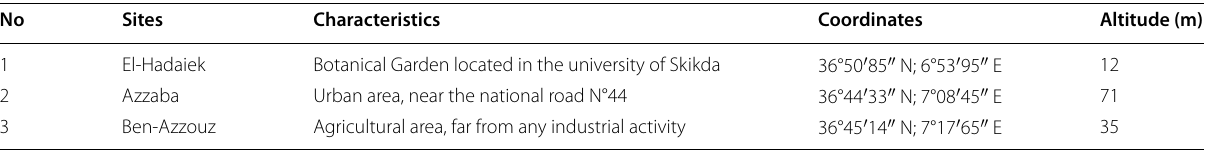
Table 1 Characteristics of the study areas